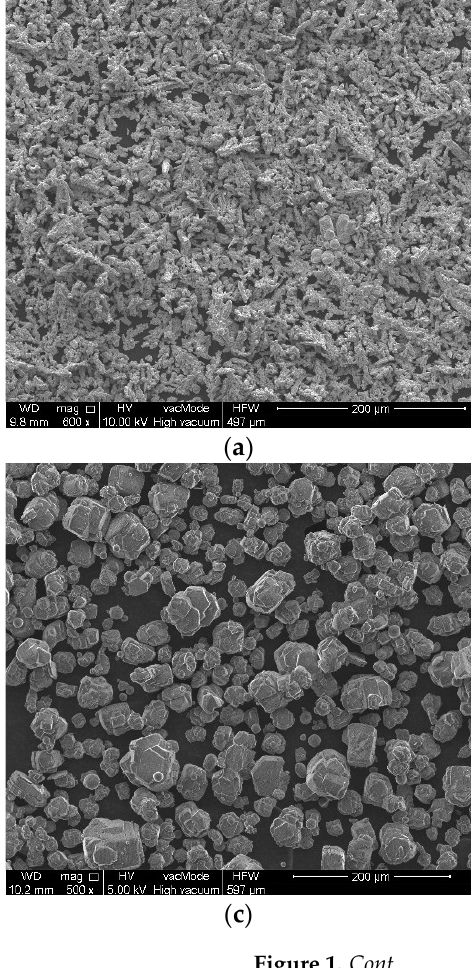
( f ) Figure 1. SEM microscope images for the applied powders: ( a ) copper; ( b ) quartz sand; ( c ) Al 2 O 3 ; ( d ) aluminum; ( e ) crystalline silica; and ( f ) microballoon. Each powder is characterized by both a different shape and grain size. Grain size measurements were obtained using SEM and are shown in Figure 2.